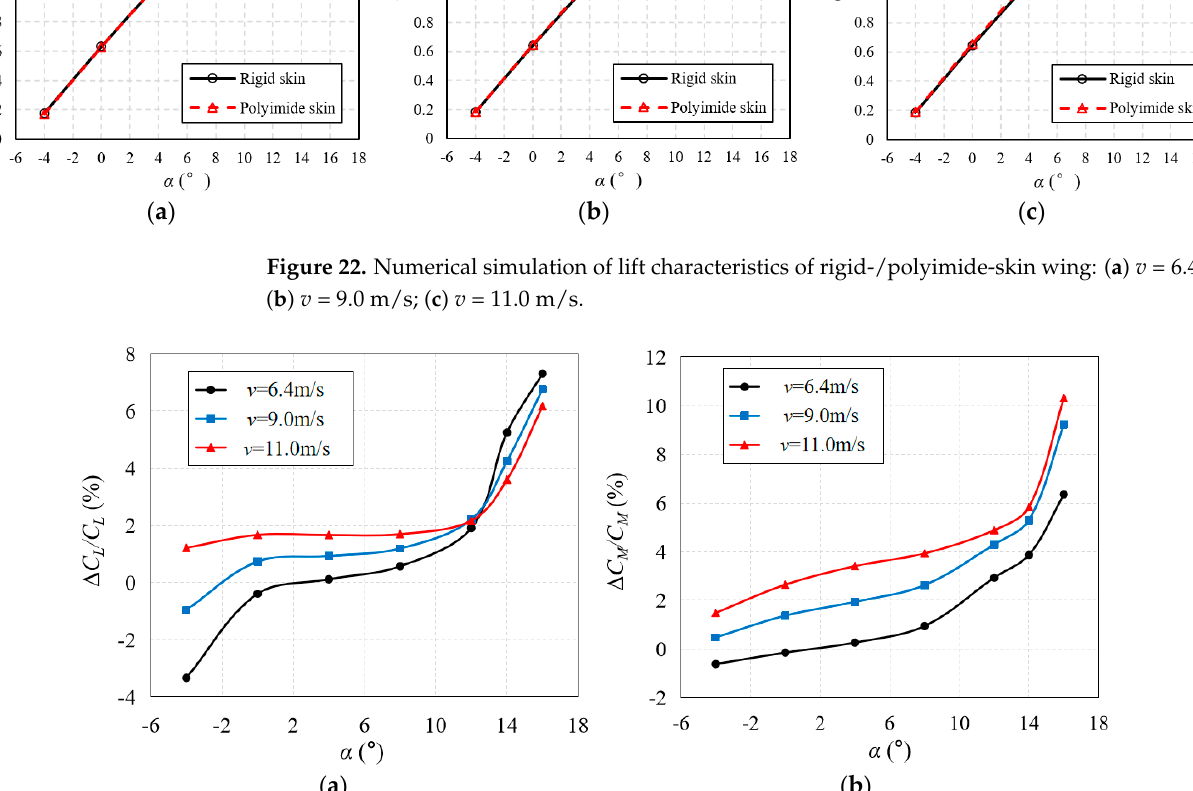
Figure 23. Variation rate of aerodynamic coefficient under different inflow velocity: ( a ) Δ C L / C L - α ; ( b ) Δ C M / C M - α .